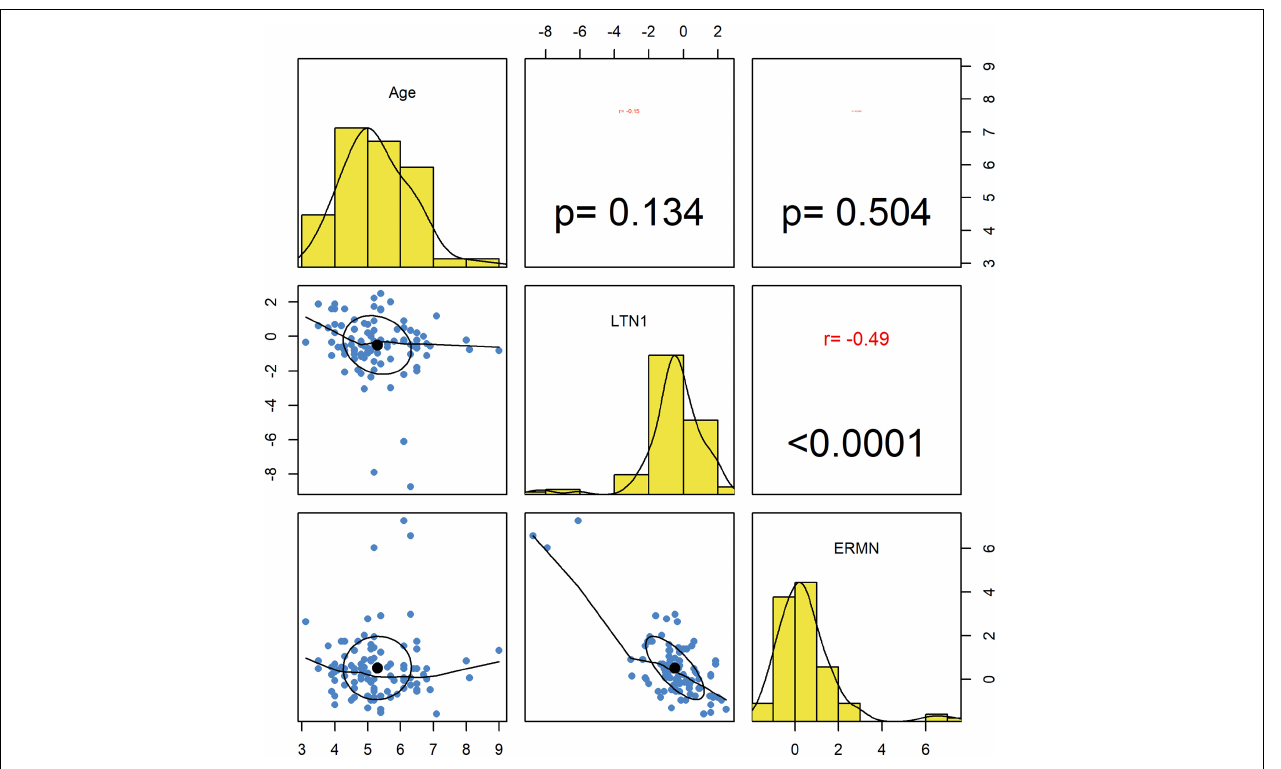
FIGURE 2 | Correlations between ERMN and LTN1 genes’ expression levels and age. The distribution of variables is presented on the diagonal. The lower portion of the diagonal shows bivariate scatter plots with a fitted line. The upper part of the diagonal demonstrates correlation coefficients and P -values.